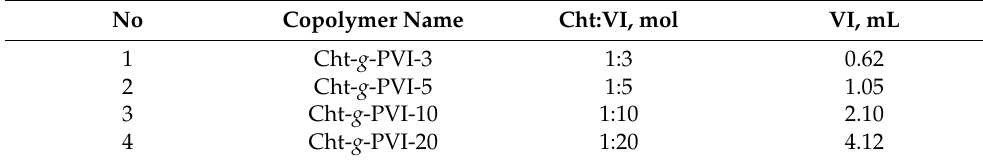
Table 1. Copolymer synthesis